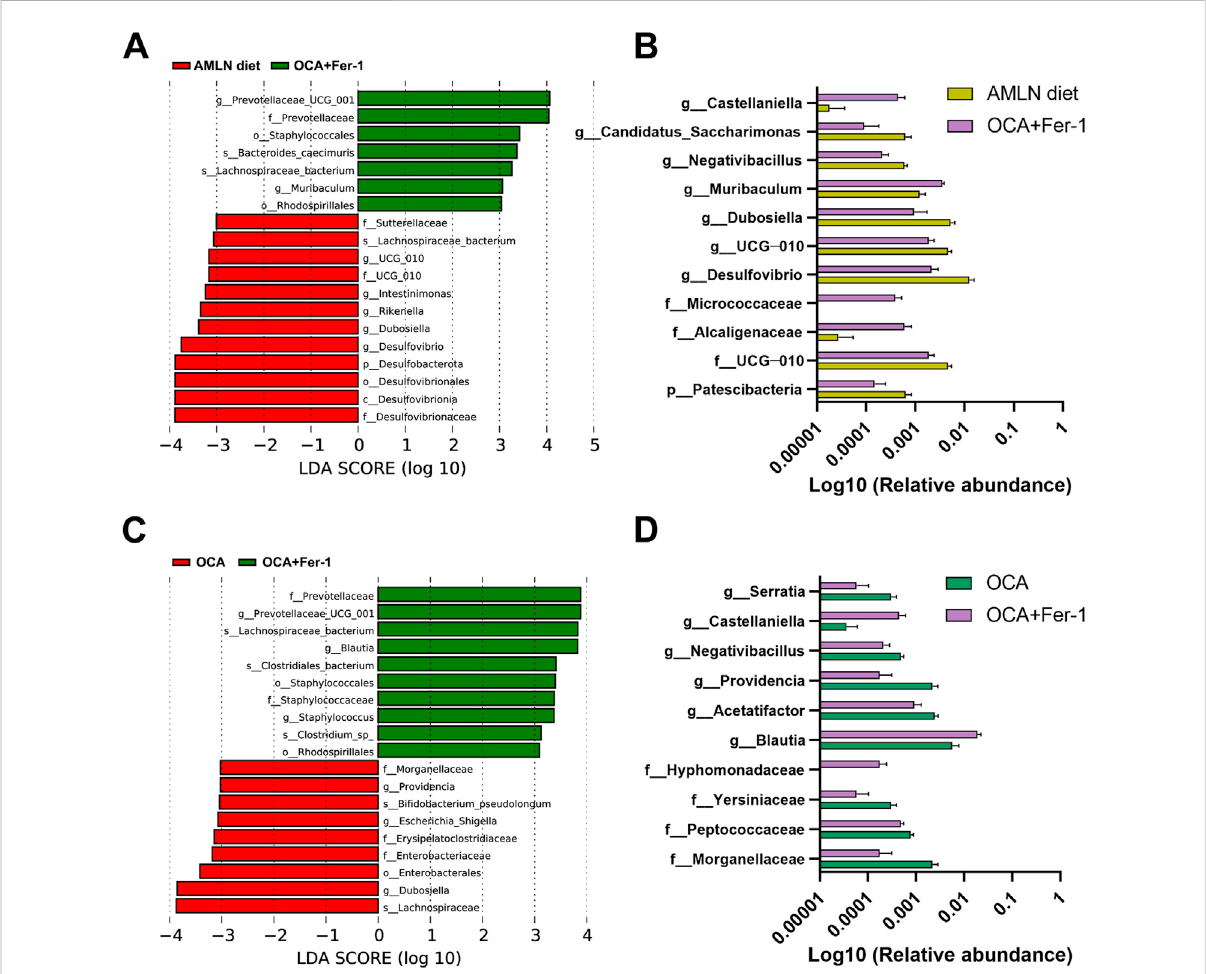
ThecombinationofOCAandFer-1differentiallyreshapedintestinalmicrobiome. (A) LEfSecladogramrepresentsthetaxaenrichedintheAMLN diet group and the OCA + Fer-1 group. (B) Taxa with signi fi cant differences between the AMLN diet group and the OCA + Fer-1 group. (C) LEfSe cladogram represents the taxa enriched in the OCA group and the OCA + Fer-1 group. (D) Taxa with signi fi cant differences between the OCA group and the OCA + Fer-1 group. Data are shown as mean ±